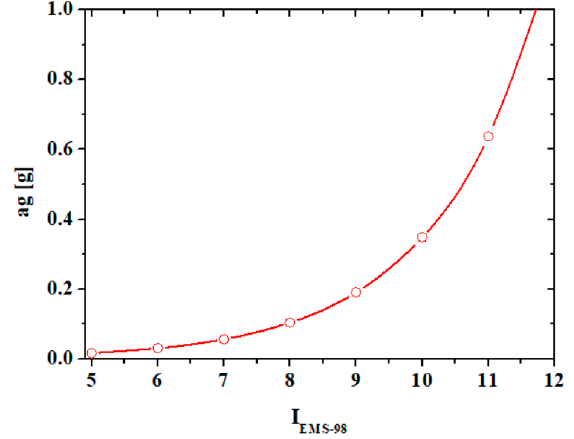
Figure 14. Correlation between macroseismic intensity I EMS-98 and a g .